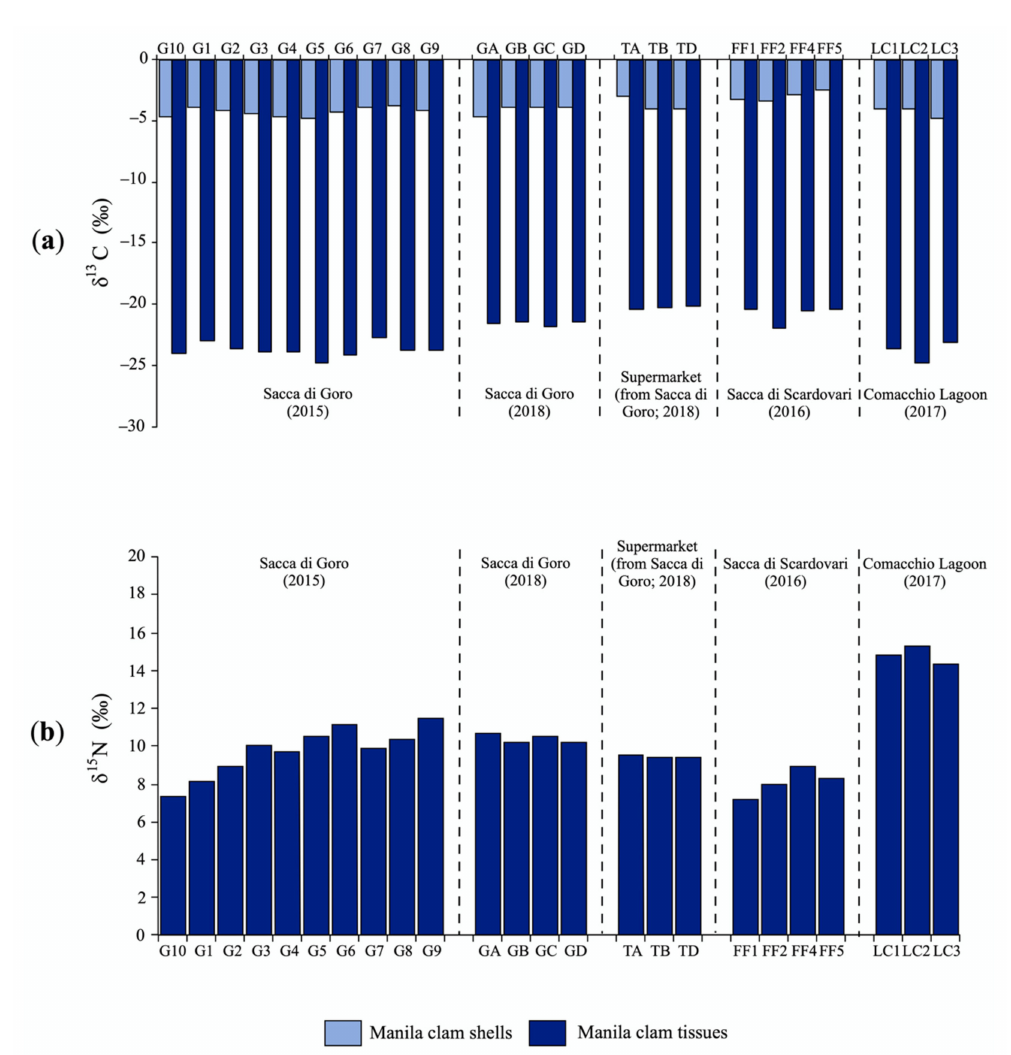
Figure 2. ( a ) Carbon (C) isotopic composition of carbon of shells and tissues and ( b ) nitrogen (N) isotopic composition of tissues of manila clam samples collected onsite from north-western Adriatic lagoons and bought at the local